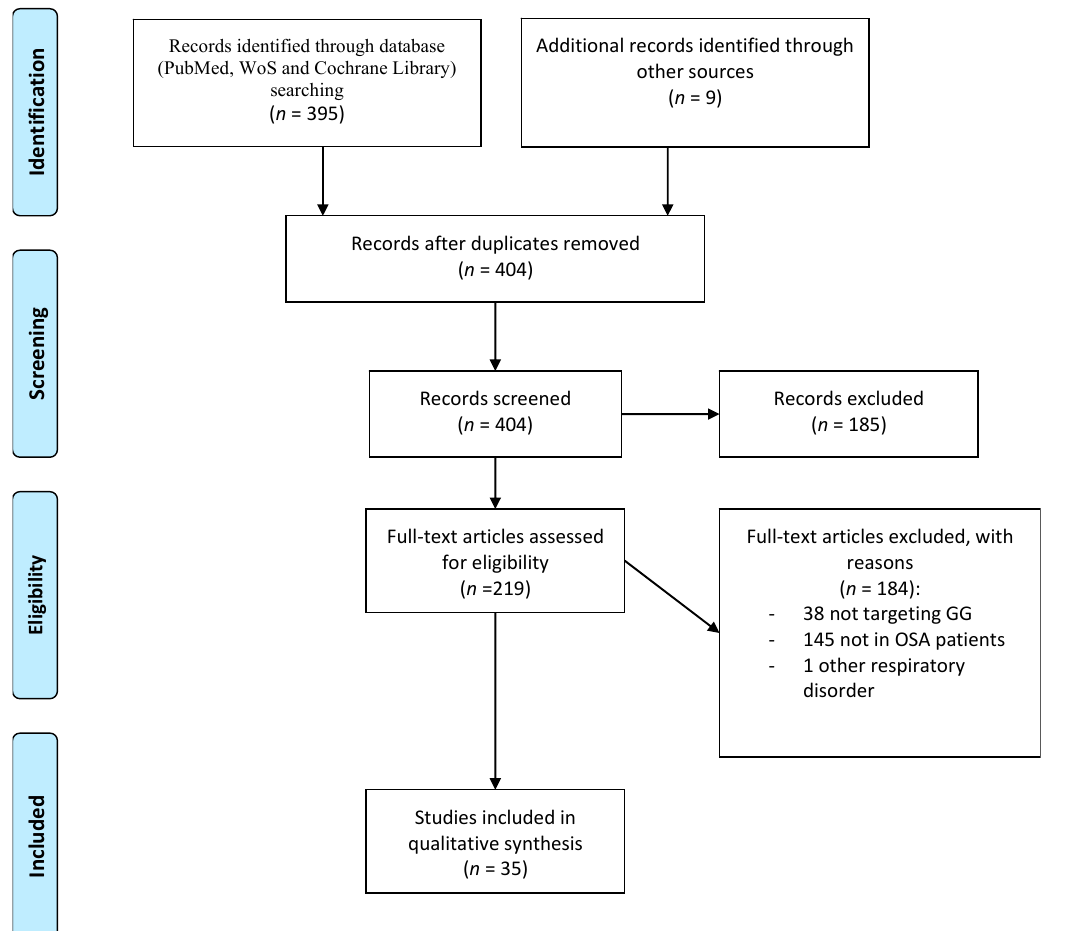
Figure 2. Schematic flow chart for the selection of studies.